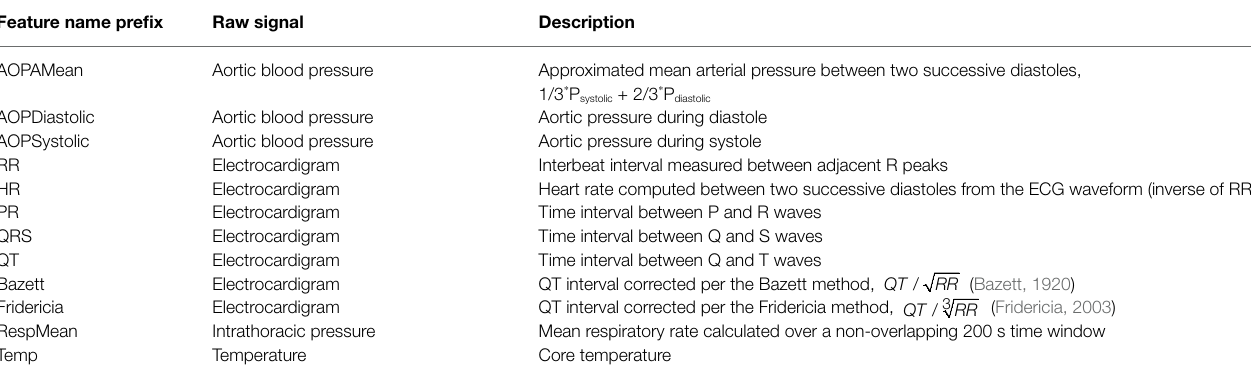
TABLE 2 | List of extracted physiological features and the raw waveform from which they are derived. Feature name prefix Raw signal